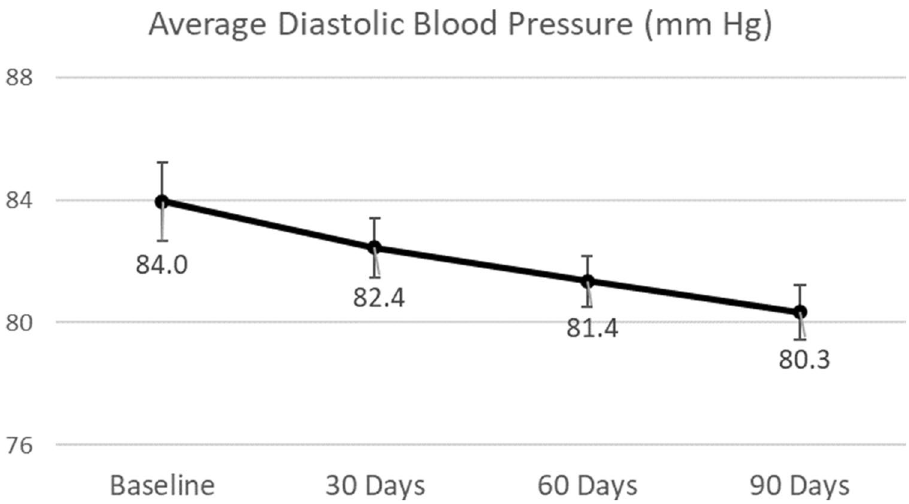
Figure 2. Changes in diastolic blood pressure. Vertical bars represent standard errors.